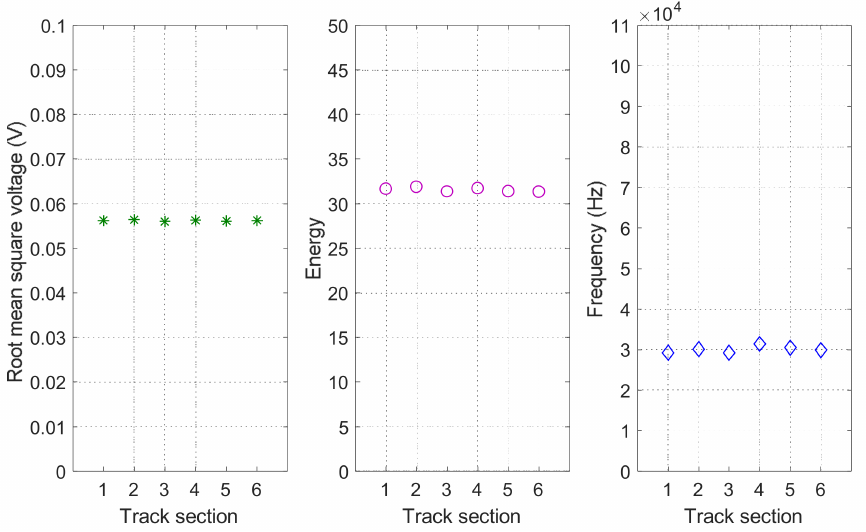
Figure 21. Spatial dependencies of features [ V RMSi E i f Pi ] for six neighbouring track sections S i , i = 1, 2, . . . , 6 in rail no. 2 under free status.